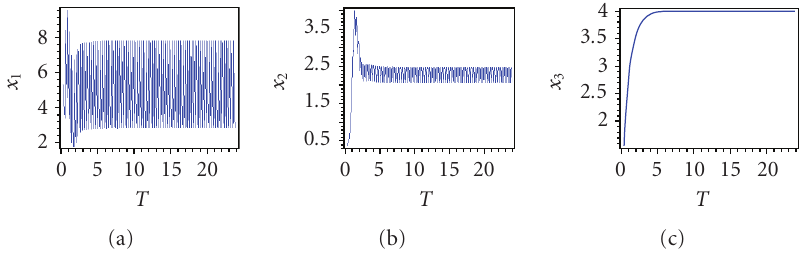
Figure 5.2. Permanence of system (1.2): (a) time series of the nutrient, (b) time series of the microor- ganism, (c) time series of the toxicant in the organism, p = 5, q = 4, T = 0 . 299.